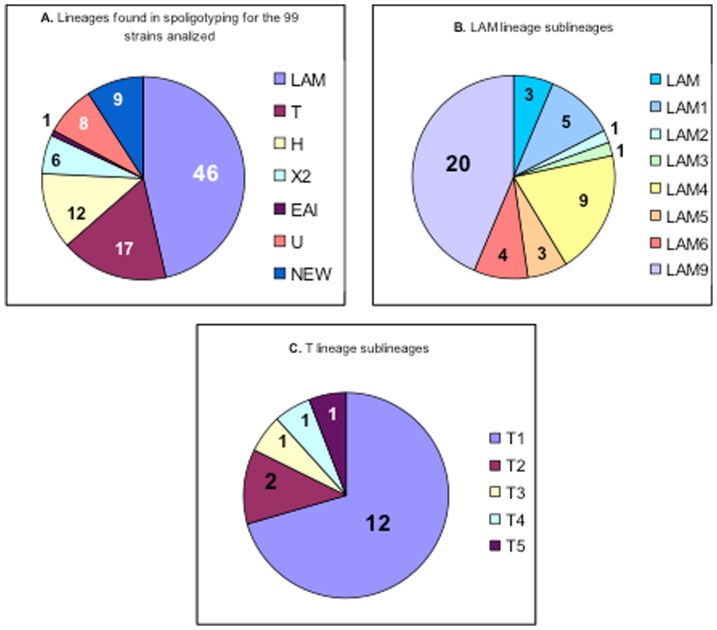
Spoligotyping analysis of MDR-TB isolates.Eighty-two isolates were classified into 5 distinct lineages (Figure 1A). Isolates of LAM Family were distributed into 8 sublineages (Figure 1B) and Isolates of T Family were distributed into 5 sublineages (Figure 1C). U – Unknown, LAM - Latin-America and Mediterranean, T - T super-family, H - Haarlen, EAI - East African Indian.